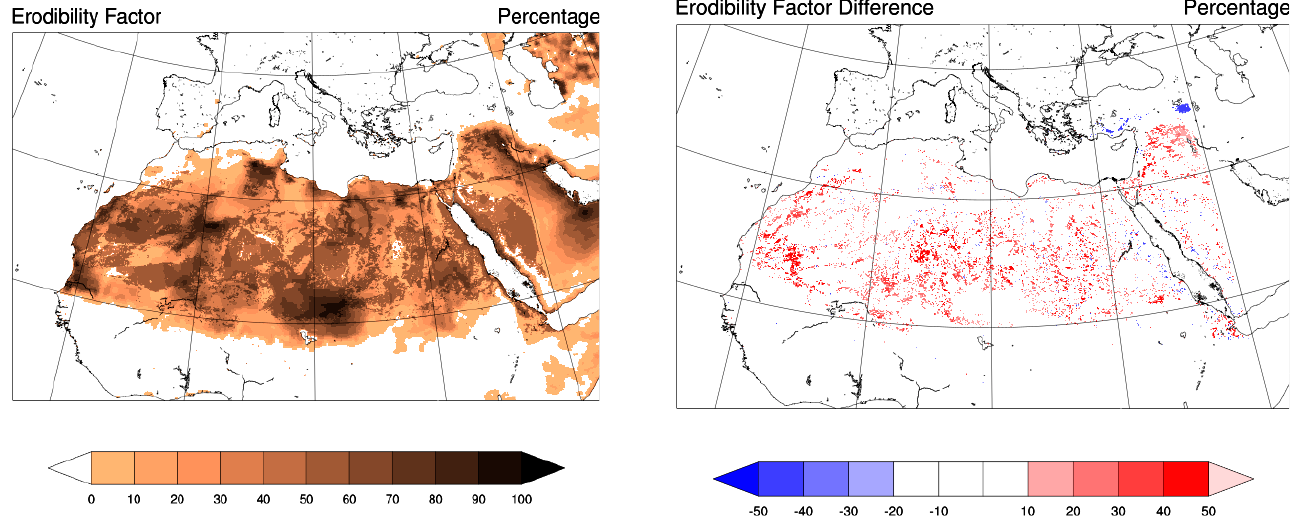
Figure 2. Erodibility factor (%) for the original WRF-Chem setup ( top left ) and the updated erodibility based on NDVI for the period 1–16 of April ( top right ). Additionally, the updated erodibility based on NDVI for the period 17–31 of May is presented ( bottom left ). The difference in erodibility between 1–16 of April and 17–31 of May is shown in the ( bottom right ) plot. All the maps are at 12 km × 12 km resolution.